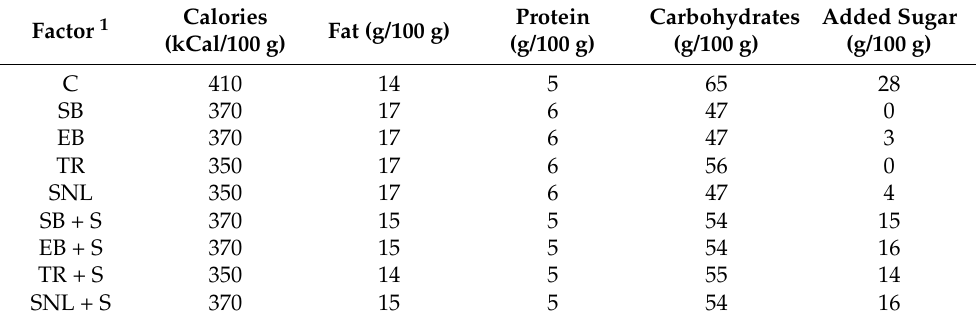
Table 7. Summary of nutrition profile information calculated using